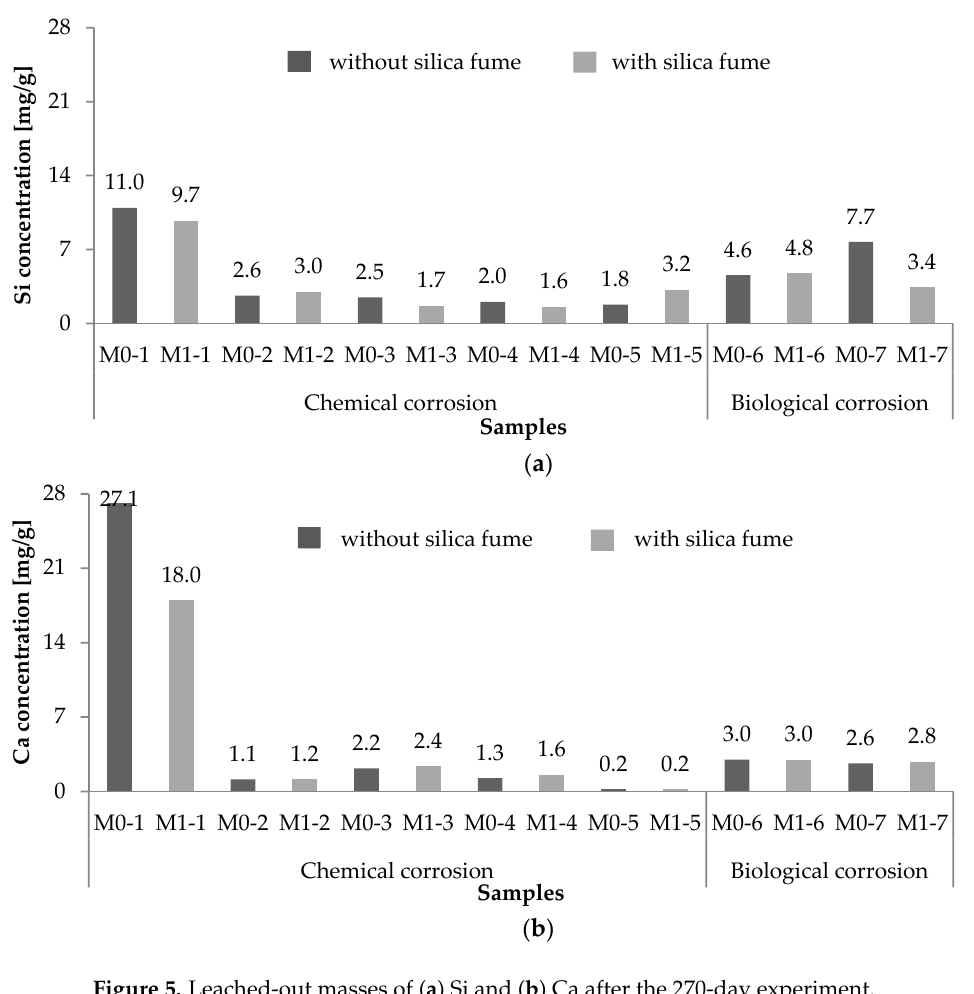
Figure 5. Leached-out masses of ( a ) Si and ( b ) Ca after the 270-day experiment.